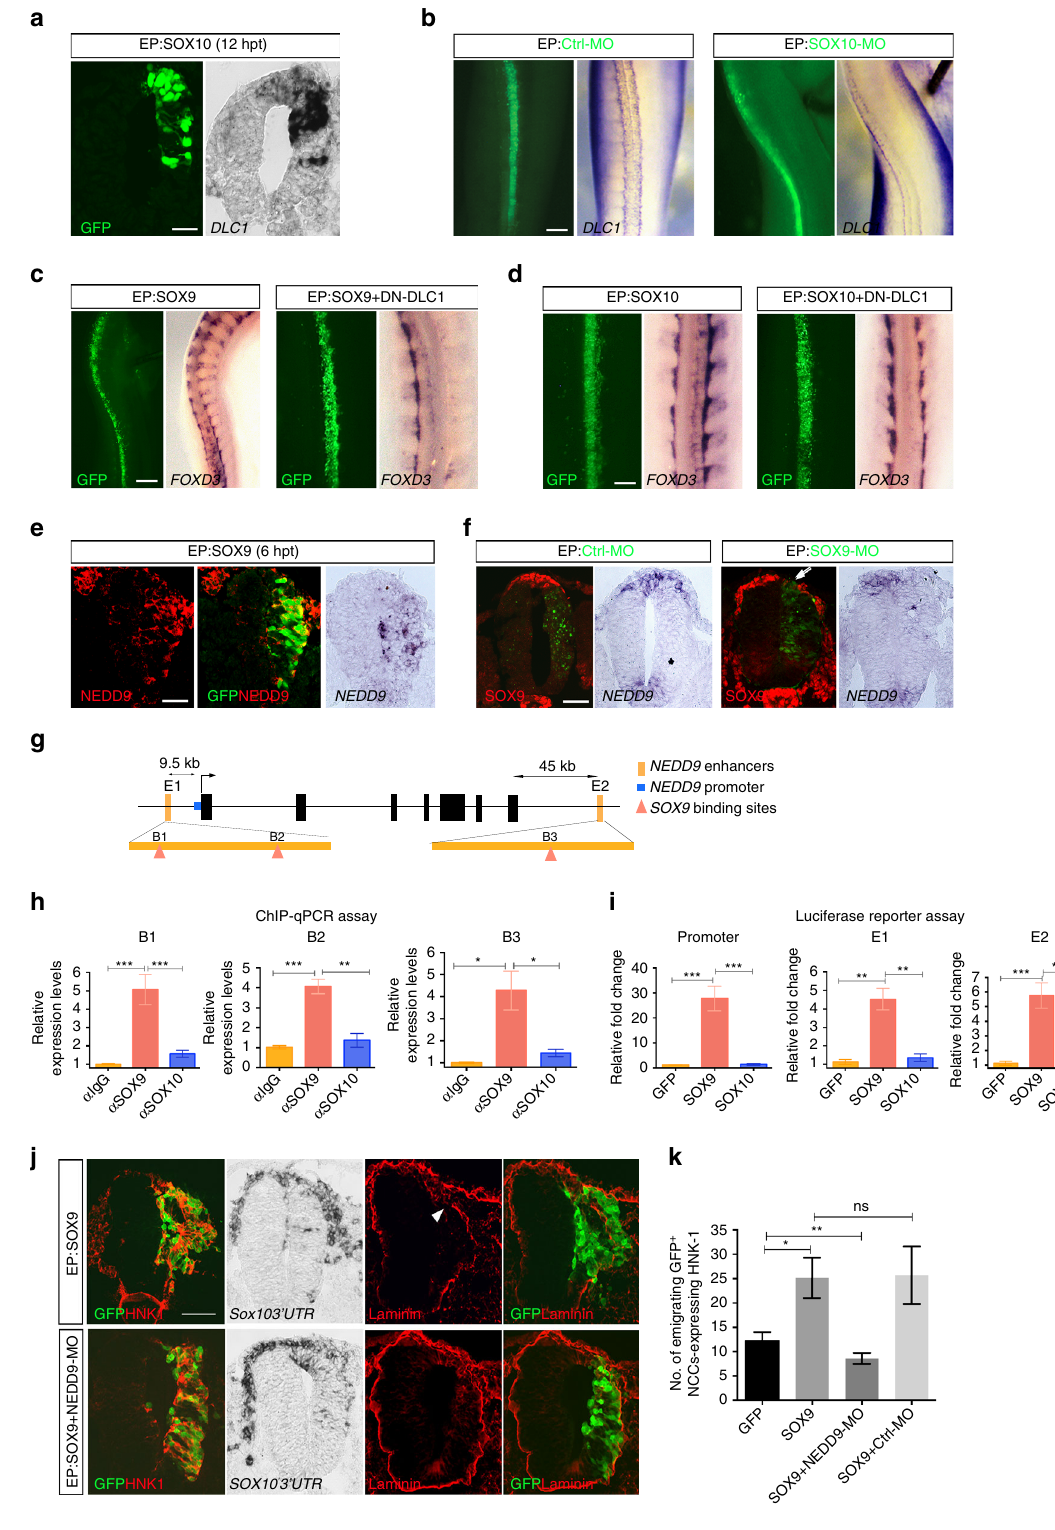
Chick embryos . Fertilized chick eggs were obtained from Jinan Poultry Co. (Tin Hang Technology) and were incubated at 38°C in a humidi fi ed incubator (Brinsea Octagon 250 incubator). Embryos were staged according to Hamburger and Hamilton (HH) 14 . The Committee on the Use of Live Animals in Teaching and Research, the University of Hong Kong has approved all animal